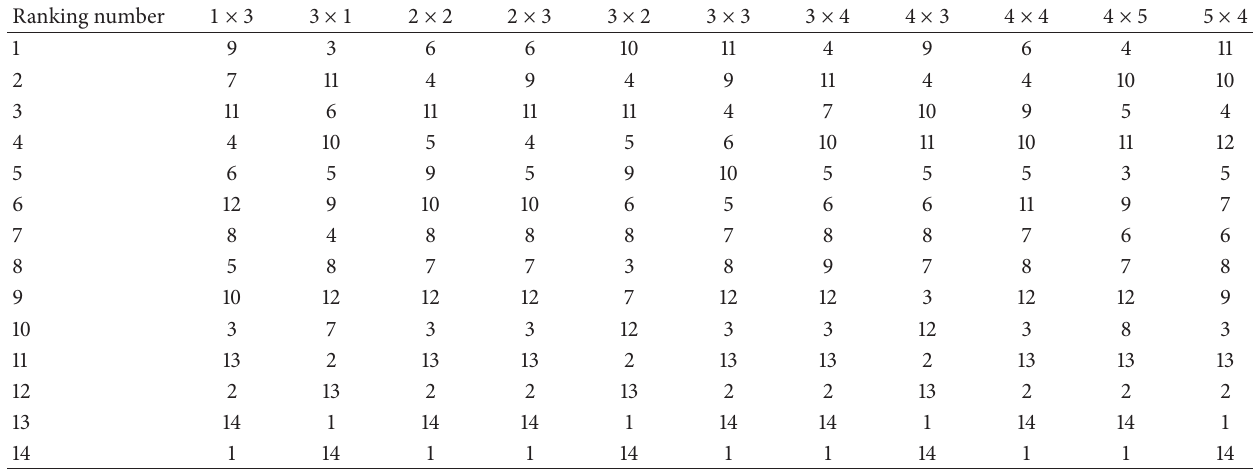
Table 2: Performance ranking of cipher text image by descending order in Figure 3 with different neighborhood selections.